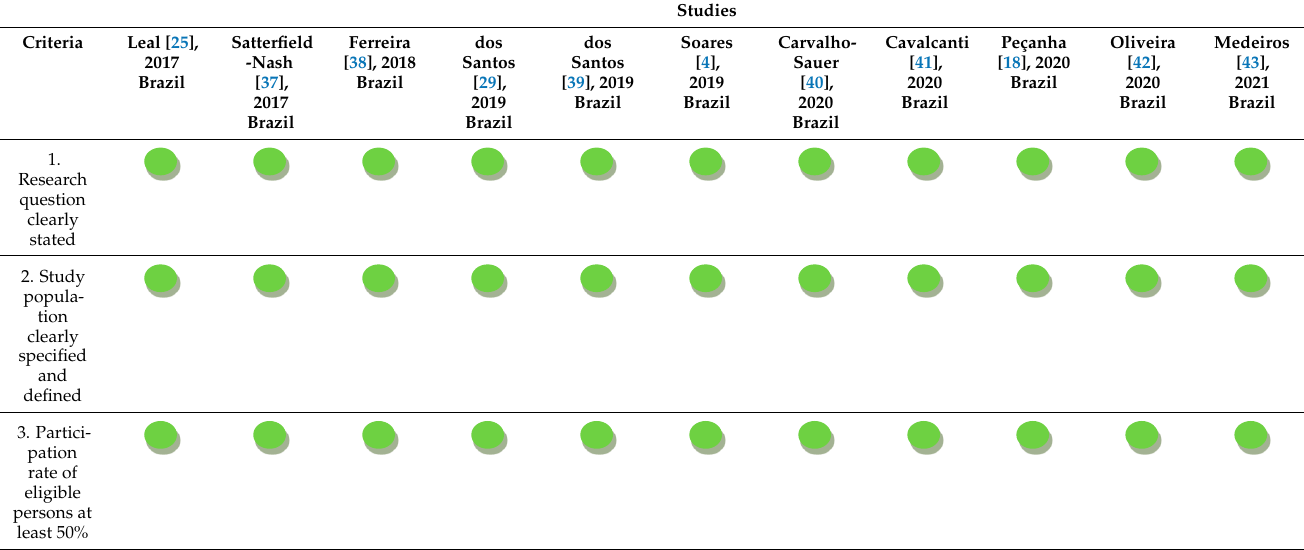
Table 1. Methodological quality and risk of bias of included articles.